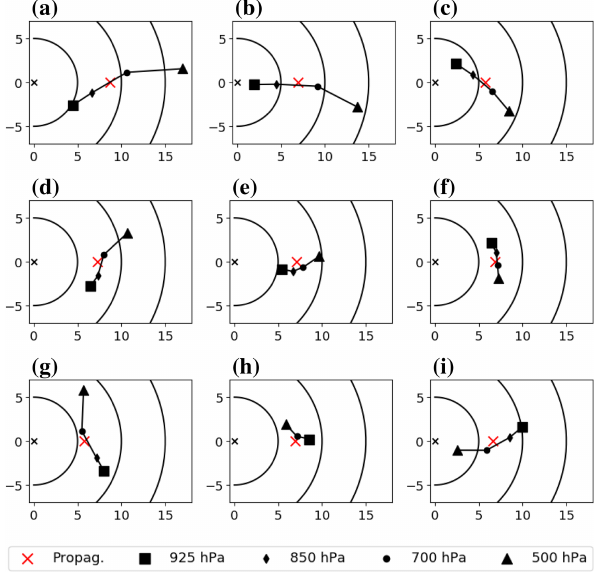
Figure 3. The mean hodographs associated with each SOM node displayed with the propagation direction towards the right. The square, diamond, circle, and triangle mark the node-mean area- mean wind vector at 925, 850, 700 and 500hPa, respectively. The mean wind vectors are rotated with respect to the propagation vec- tor of the polar low (red cross). Units on the x and y axes are ms − 1 . The origin is marked by a black “x” and black circular lines denote mean wind vectors with a strength of 5, 10, and 15ms − 1 . Table 1. Definition of the vertical-shear categories as depicted in Fig. 4. Category